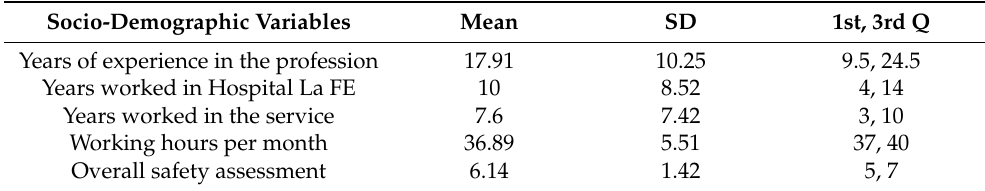
Table 1. Socio-demographic